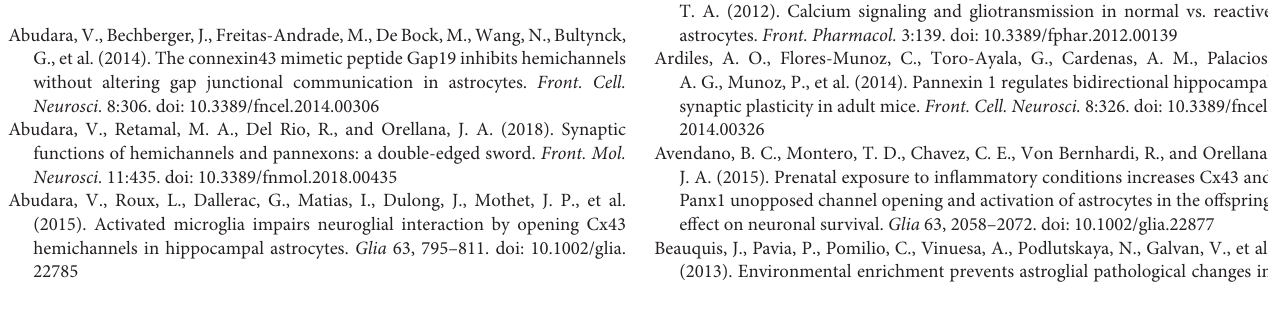
[Ca 2 + ] i oscillations by hippocampal astrocytes in acute slices from control offspring (white bar) or prenatally LPS-exposed offspring of 4 months old alone (black bars) or in combination with 0.5 µ M TTX and the following pharmacological agents: 100 µ M gap19, 100 µ M Tat-L2, 100 µ M 10 panx1, 500 µ M Probenecid